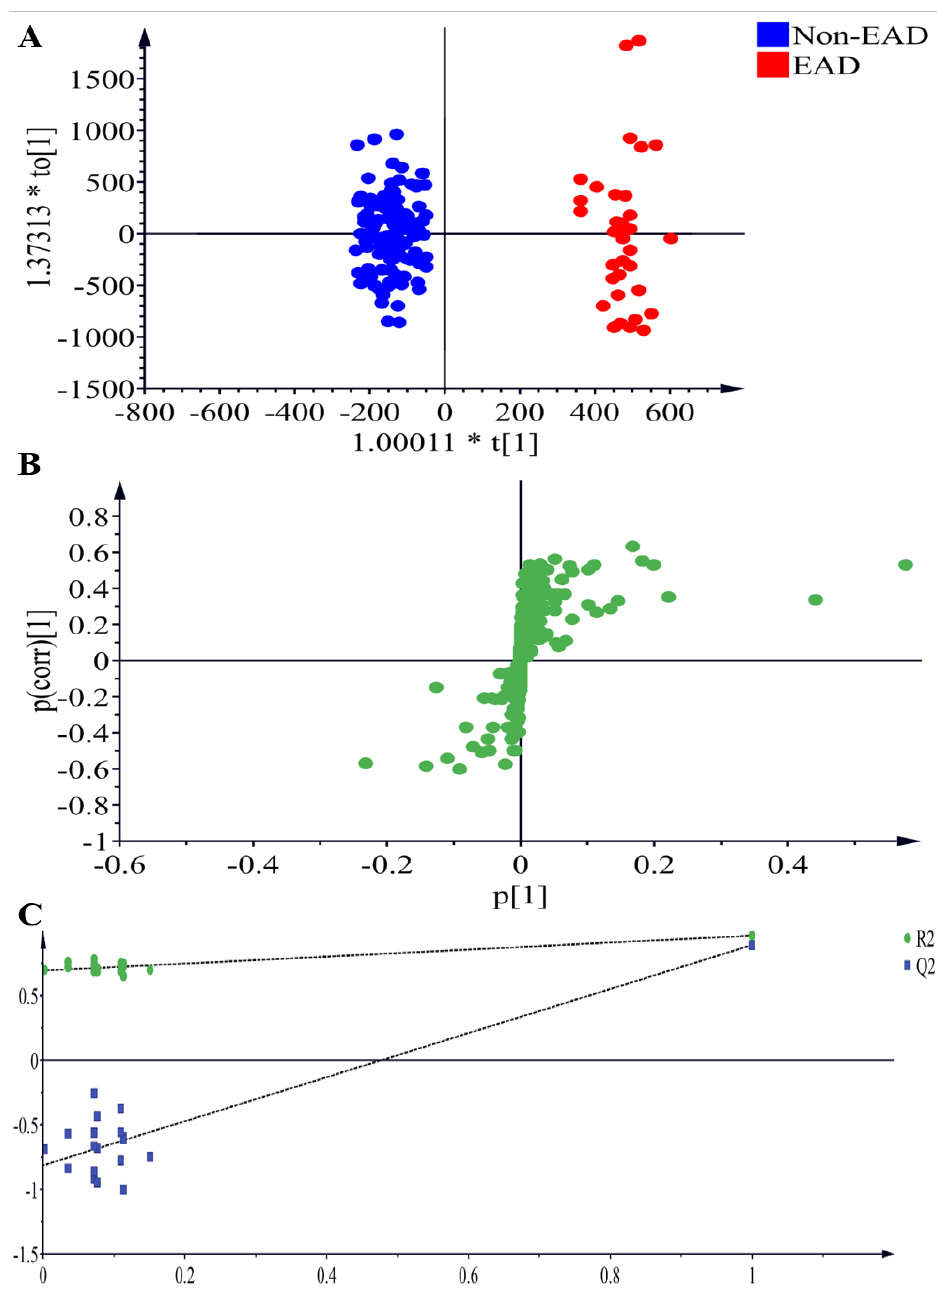
Figure 3. Plasma samples analyzed by LC-MS in electrospray positive ion mode, comparing EAD and nonEAD recipients. ( A ) OPLS-DA scores plot presenting T6 EAD (red) and T6 Non-EAD (blue) with fitness and predictive power R 2 X = 0.895, R 2 Y = 0.965, Q 2 = 0.893. ( B ) Metabolites with significant differences in electrosrapy positive ion modes between normal EAD and Non-EAD are presented in S-plots. ( C ) Validation of the OPLS-DA model by a class permutation analysis for ( A ). LC-MS, liquid chromatography coupled with mass spectrometry; OPLS-DA, orthogonal projection to latent structures-discriminant analysis; EAD, early allograft dysfunction.